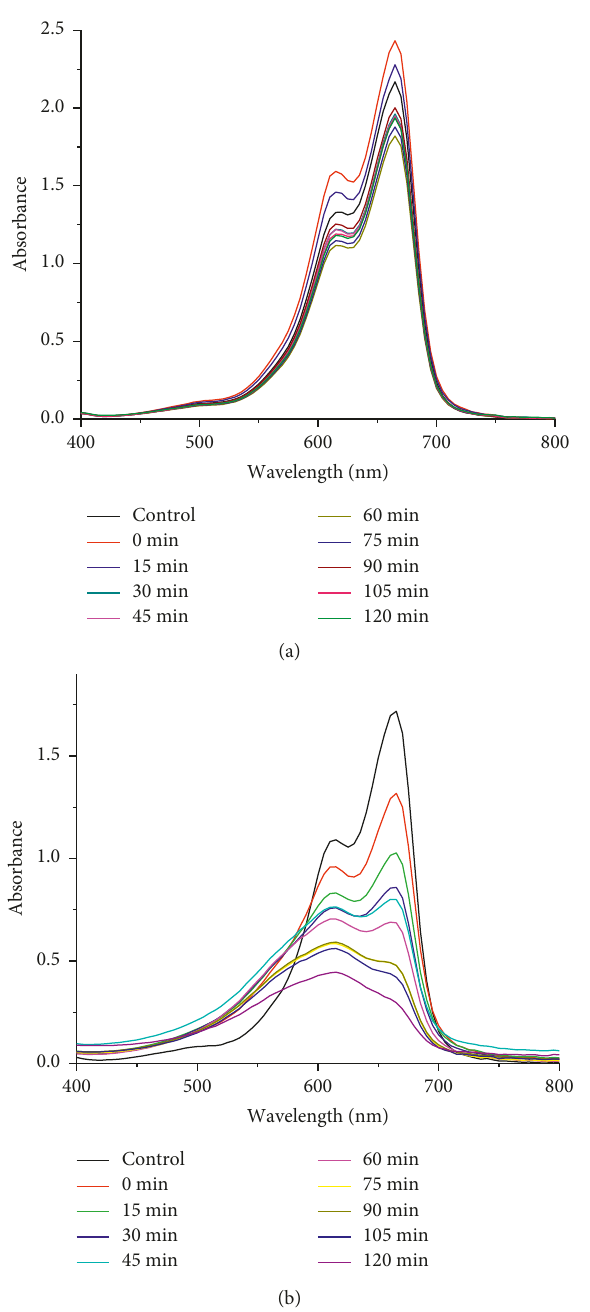
Figure 4: Absorbance curves of MB solution (light): (a) raw egg shell powder; (b) calcined egg shell powder.